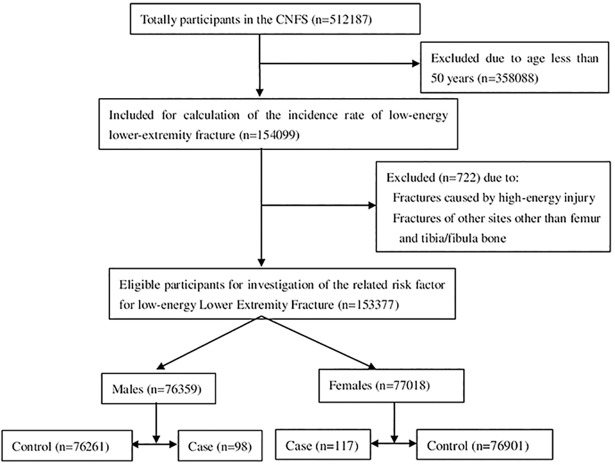
The flow chart for inclusion of the participants.